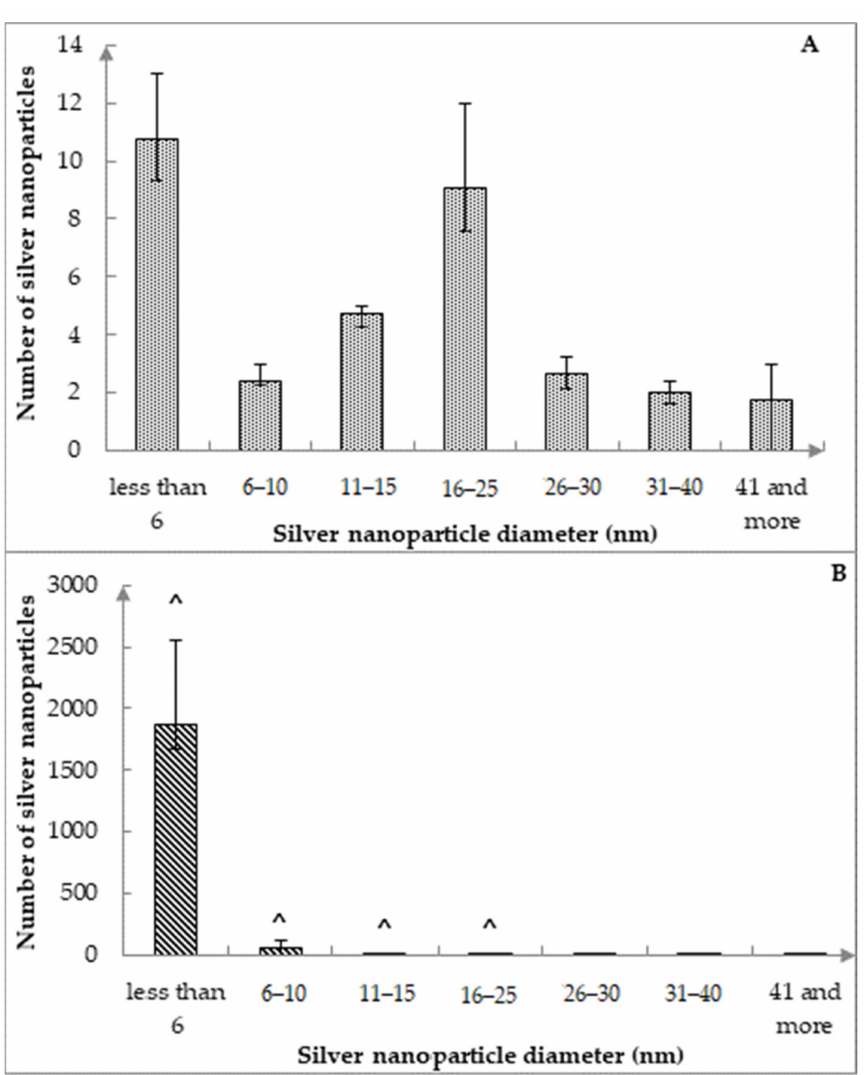
Figure 7. Distribution of silver nanoparticles on the surface of silk without exposure to temperatures below 0.0 ◦ C ( A ) and after 10-fold cyclic freezing ( B ). Note: ˆ— p < 0.05, compared to the corresponding size range before cyclic freezing; data are presented as Me, P 25 , P 75